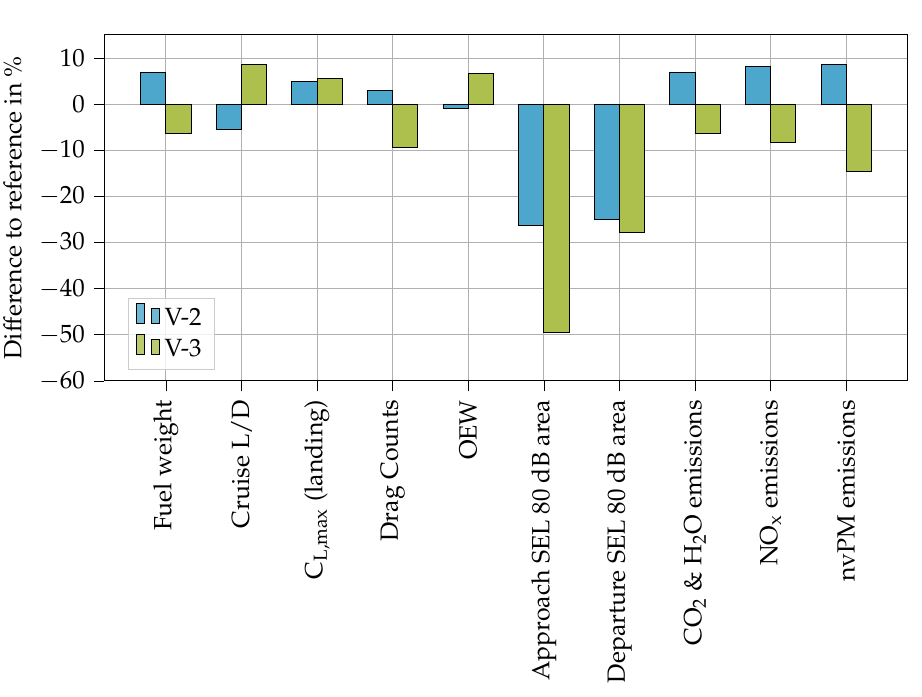
Figure 15. Difference of V-2 and V-3 to the reference design V-R ( ceo